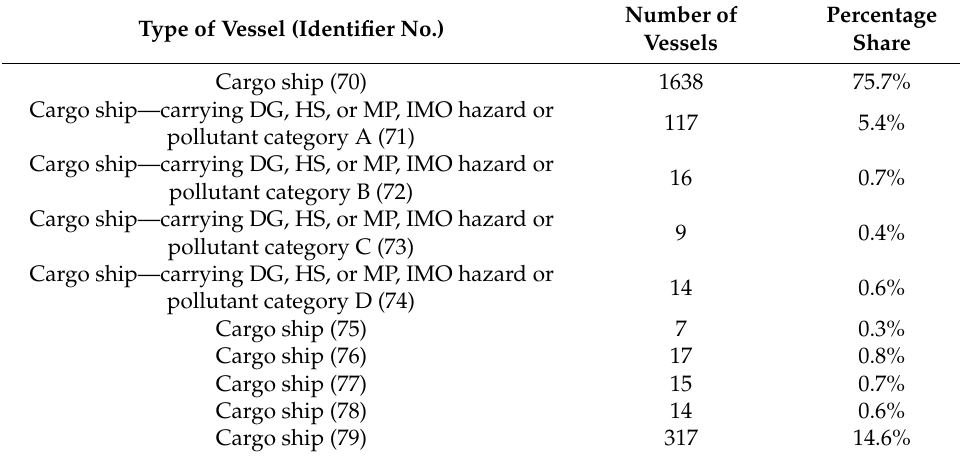
Table 6. List of unique passenger ships staying in the waters in 2017, broken down by type.